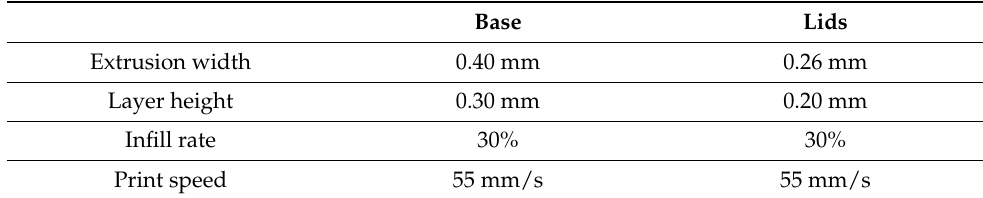
Table 2. Printing settings for circuit